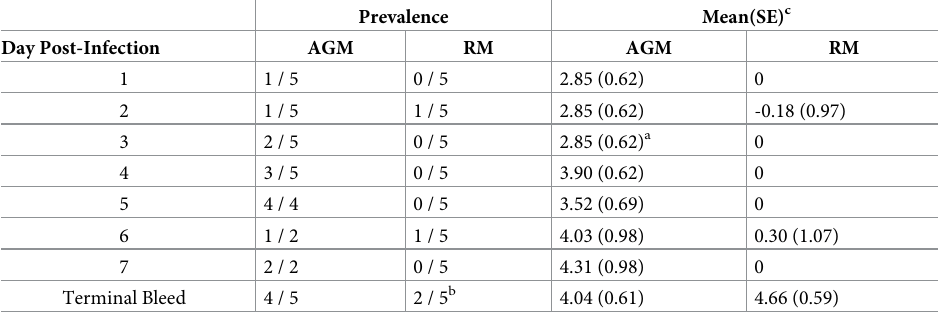
a One animal with “too numerous to count” values at all dilutions was imputed to 3500 CFU/mL. b Terminal end point for RMs was day 46 or day 47 except for one RM with day 13 as terminal end point. The median time to death in the AGM group was 5 days (95% CL5.0–13.0). c Mean Log 10 CFU/mL for blood and urine, or Log 10 CFU/g tissue for other organs. SE represents standard error computed under a negative binomial